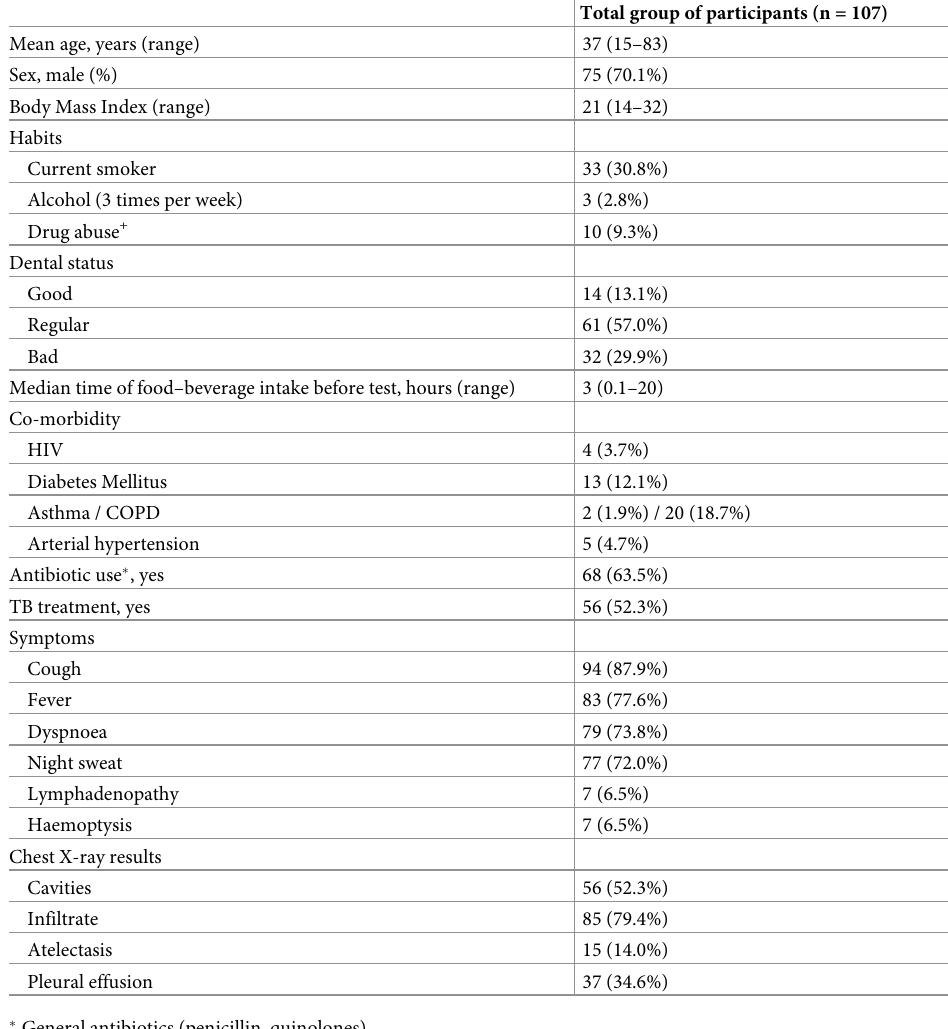
Table 1. Participant demographic table.